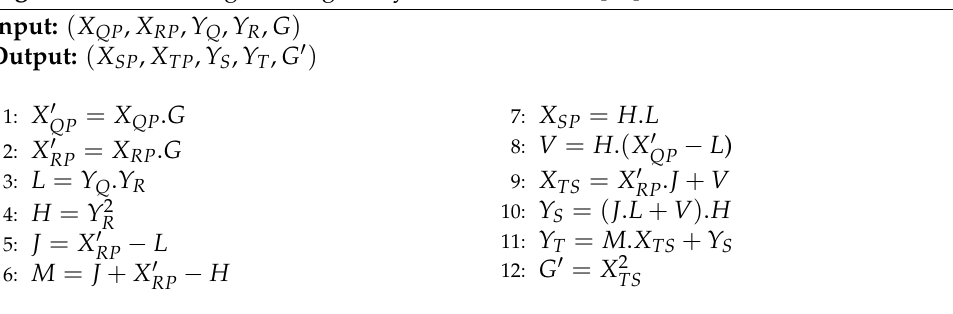
Algorithm 1 Hamburg’s Montgomery Ladder Formula